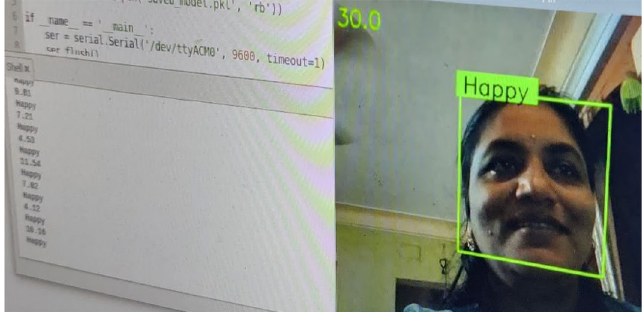
Fig. 9 The bounding box for face detection and happy emotion detection on raspberry pi camera and GSR showing skin conductance and happy emotion label and left bottom of the screen